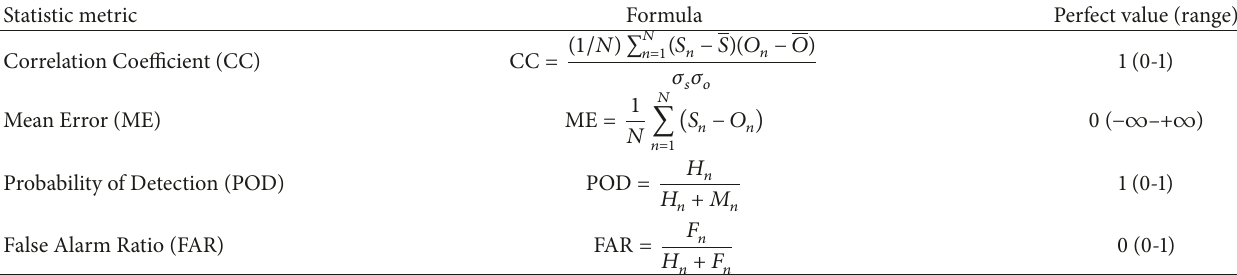
Table 4: List of the continuous and categorical verification metrics used in the evaluation.